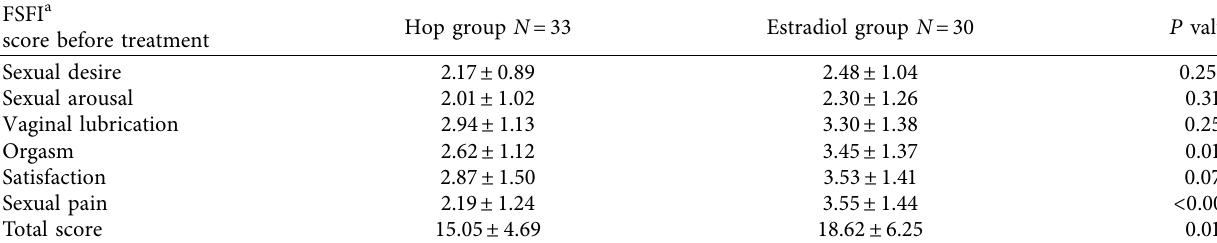
Table 2: FSFI scores of the women in the hop and estradiol groups before treatment. FSFI a